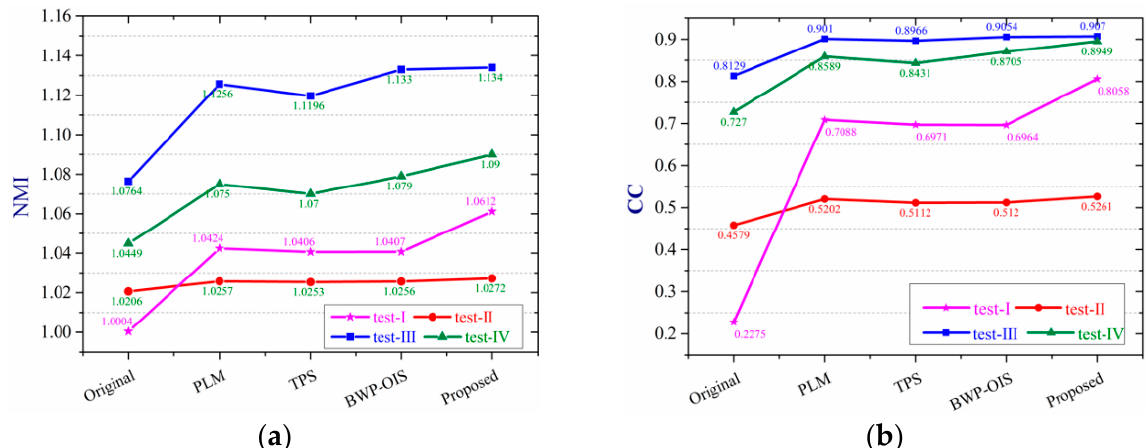
Figure 8. ( a ) NMI and ( b ) CC of the aligned results from the compared methods. As shown, the proposed method achieves the largest NMI and CC in all the experi- ments. The registration accuracy of PLM is close to that of BWP-OIS whereas the latter is slightly superior in “test-III” and “test-IV” in Figure 8. The local mapping functions of PLM are constructed by feature points, so its accuracy is limited by the precision of the feature points extraction. On that account, BWP-OIS alleviates the situation by designing